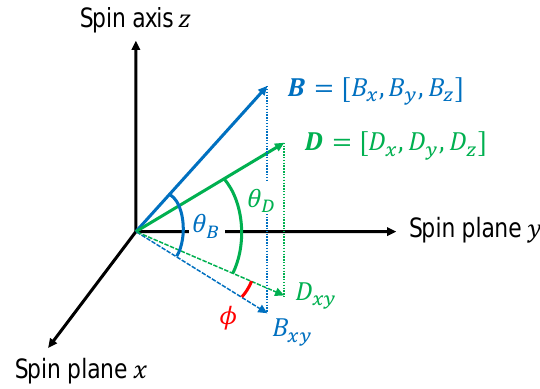
Figure 1. Sketch illustrating the magnetic field and maximum vari- ance directions B and D , their projections onto the spin plane B xy and D xy , and the angles θ B , θ D , and φ